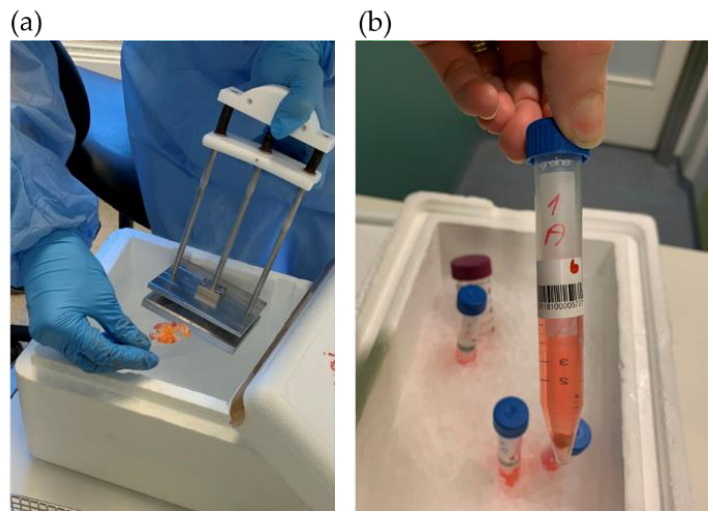
Figure 2. Tumor tissue sampling for: ( a ) biobanking and ( b ) PDX procedure.